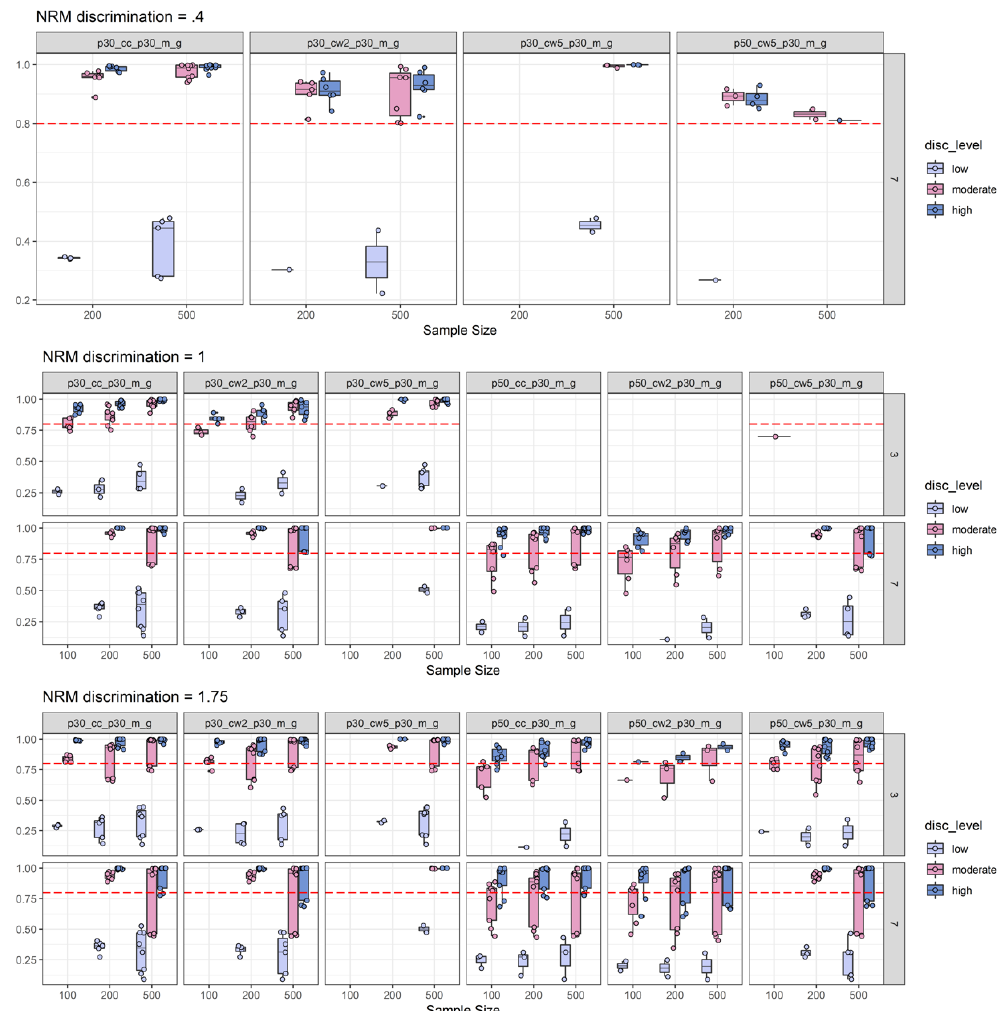
Figure A3. 2PL-discrimination split of empirical power analysis: Depiction of the empirical power (y-axis) under the boundary condition that the average γ is greater than 0.30. Power is depicted as a function of NRM discrimination, sample size (x-axis), number of distractors, 2PL-discrimination, and discrimination effect sizes combined with effect size thresholds (p30_cc_p30_m_g = canonical correlation with a 0.30 threshold; p30_cw2_p30_m_g = Cohen’s ω based on two ability groups with a